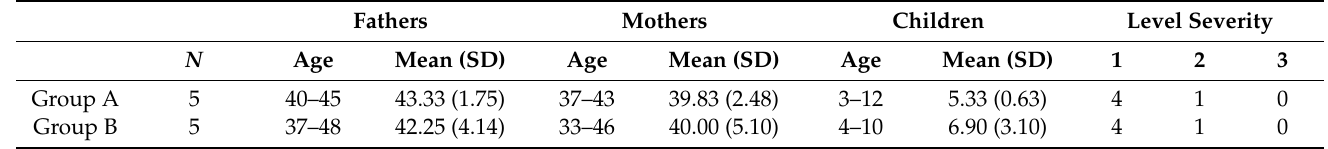
Table 1. Age of the family members (parents and child with ASD) in the initial